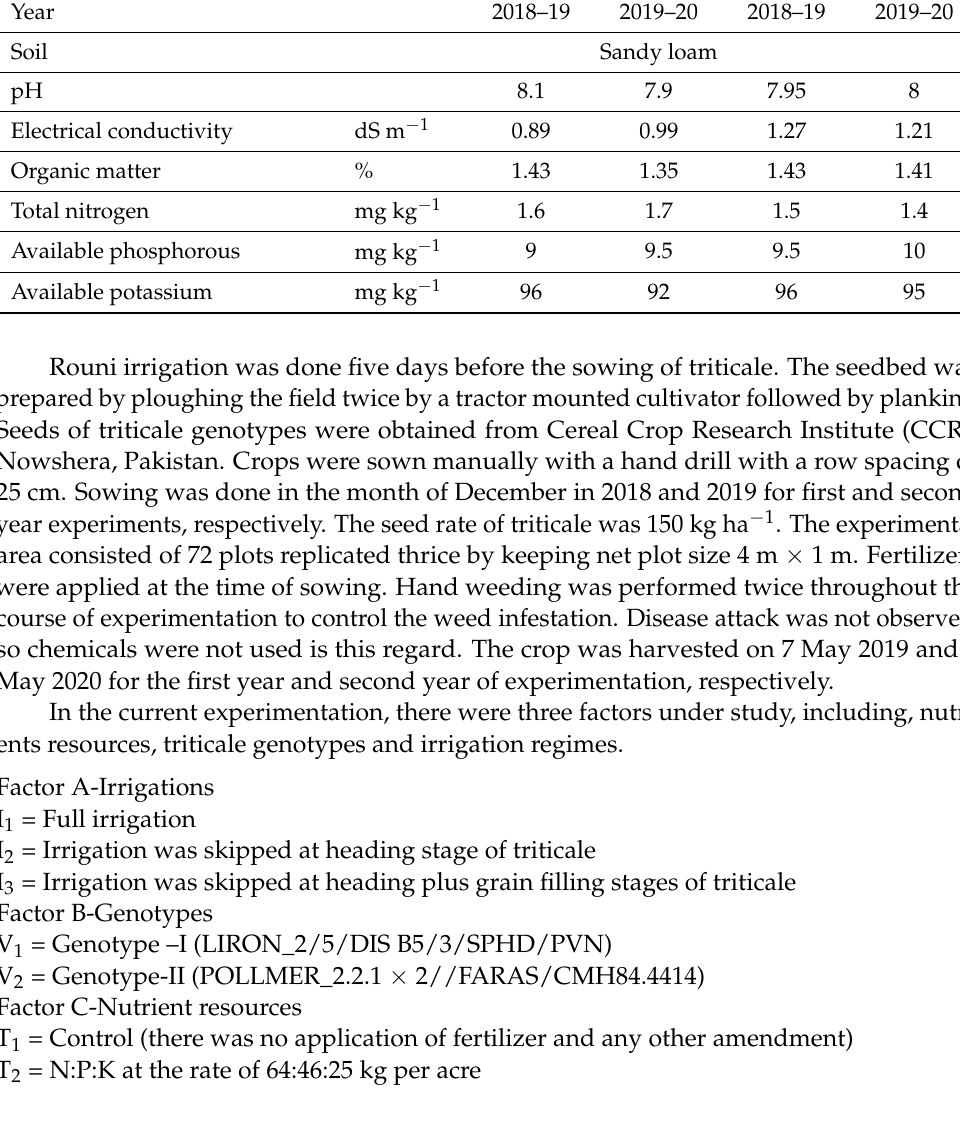
Table 1. The physical and chemical characteristics of the experimental site. Parameters